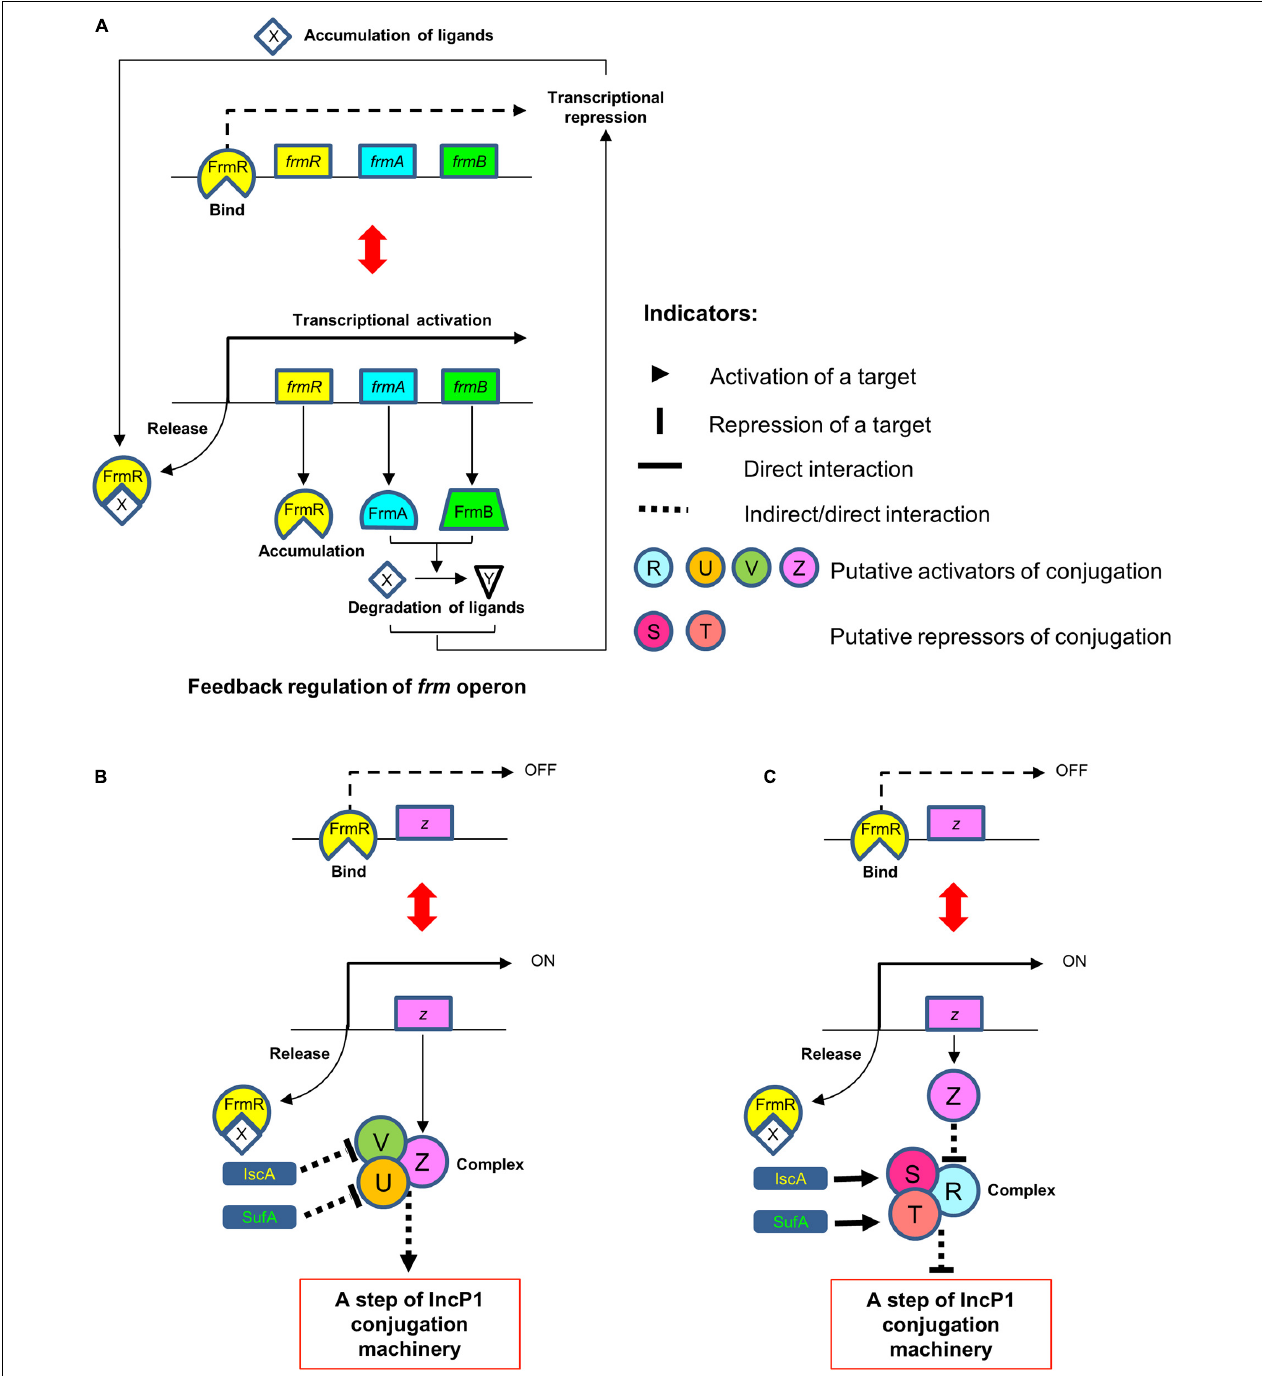
FIGURE 6 | Possible model mechanisms of the FrmR, SufA, and IscA protein interactions within E. coli donor in repressing the conjugation of IncP1 α plasmid. (A) Feedback regulation of frm operon. FrmR is a transcriptional repressor of the frm operon. The accumulation of ligands (e.g., formaldehyde) causes the inactivation of FrmR repressor activity by binding to the ligands, consequently activates the transcriptional activity of this operon. This transcriptional activation leads to the expression of the downstream genes, frmA and frmB, which encode FrmA and FrmB for formaldehyde detoxification. (B,C) FrmR is also predicted to be a transcriptional repressor on the operon of another target factor (activator) within the E. coli donor which represents as factor Z. IscA and SufA are predict to work in repressing the activators (factors V and U, respectively) either by directly or indirectly (B) or directly activate the repressors (factors S and T, respectively) (C) . At the same time, both of these activators may form a complex with the FrmR target factor (Z) in order to activate conjugation (B) or the repressor may form a complex with other factor (factor R) repressed by factor Z either directly or indirectly, resulting to the repression of conjugation (C) , either by directly or indirectly. Based on these model mechanisms, the FrmR, SufA, and IscA proteins are possible to repress the conjugation at the identical step(s) of IncP1 conjugation machinery.